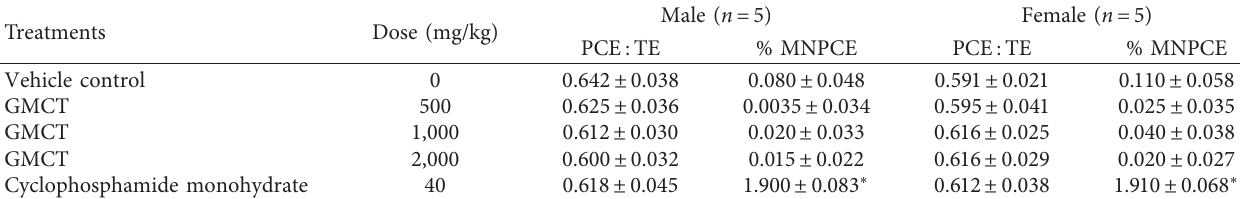
Table 14: Effect of GMCT supplementation on micronucleus frequency in mouse bone marrow erythrocytes.